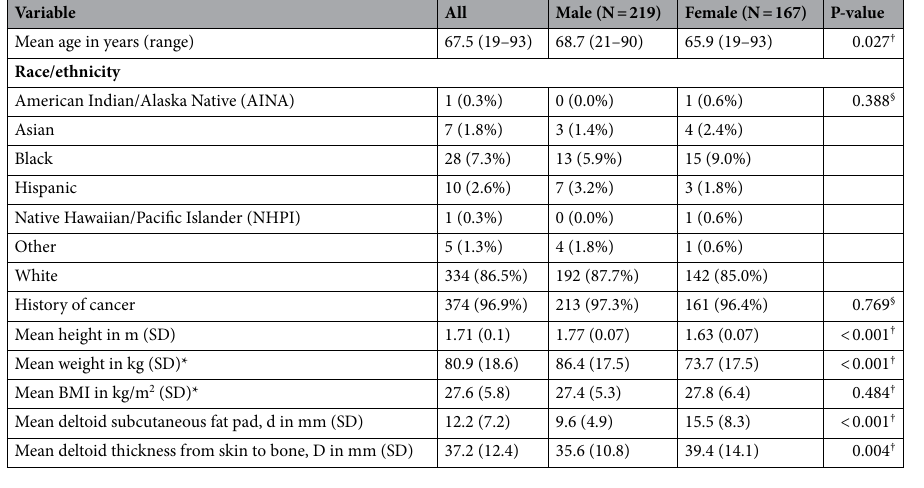
Table 1. Patient clinical and demographic characteristics. *One man and one woman did not have recorded weights at imaging. † By 2-sample t-test with unequal variances. § By Fisher’s exact